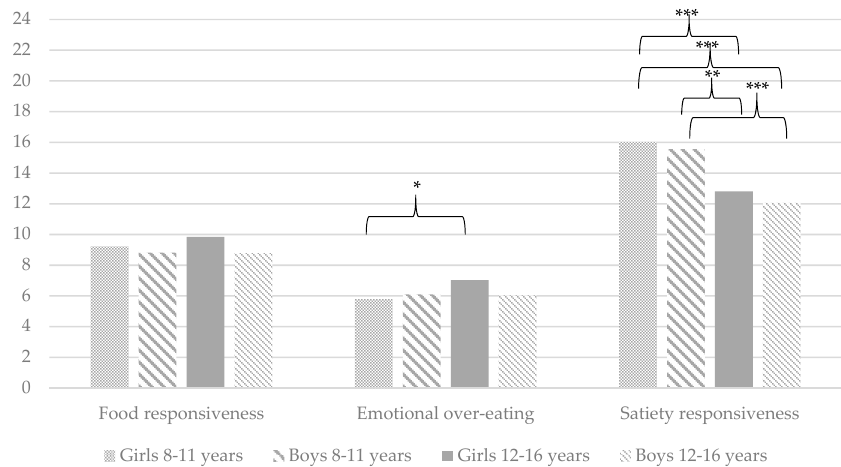
Figure 3. A mother’s perspective: Mean problematic eating behaviours measured by the Child Eating